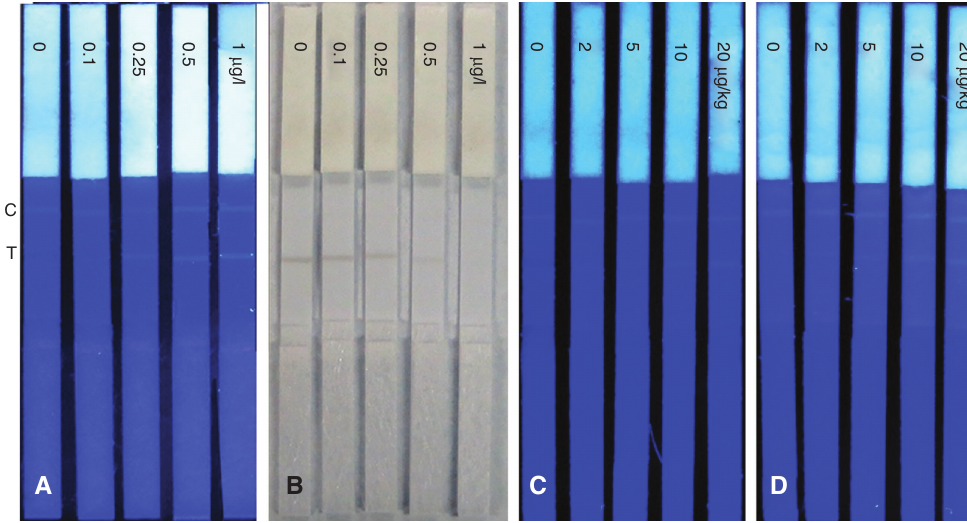
Figure 6: Detection of zearalenone (ZEN) using Au nanocomposite-based fluorescent quenching immunochromatographic sensors (B-FICSs). A series of concentrations of ZEN (0 μ g/l, 0.1 μ g/l, 0.25 μ g/l, 0.5 μ g/l, and 1 μ g/l) was prepared in pH 7.4 PBS (0.01 mol/l) and detected under (A) UV lamp and (B) natural light. A series of concentrations of ZEN was spiked into cereals and used in B-FICS (0 μ g/kg, 2 μ g/kg, 5 μ g/kg, 10 μ g/kg and 20 μ g/kg). (C) Maize. (D)